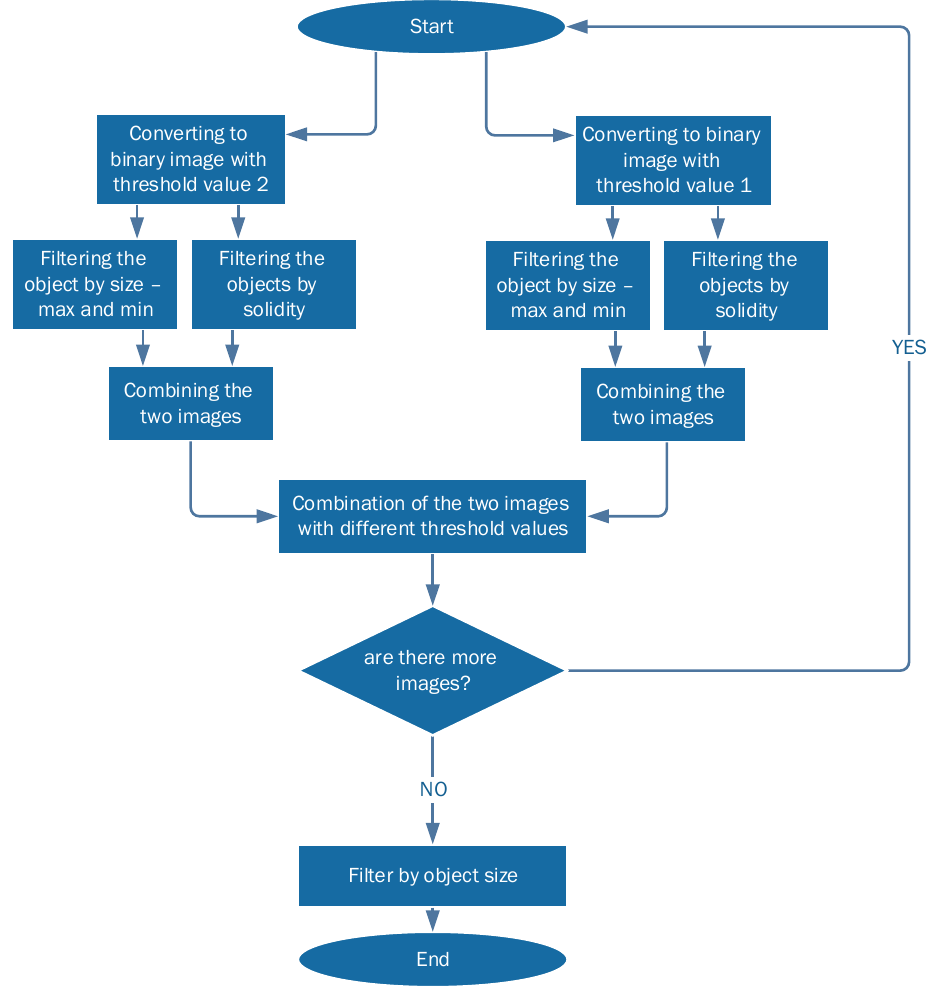
Figure 2. Solidity detection and object size filtering scheme.